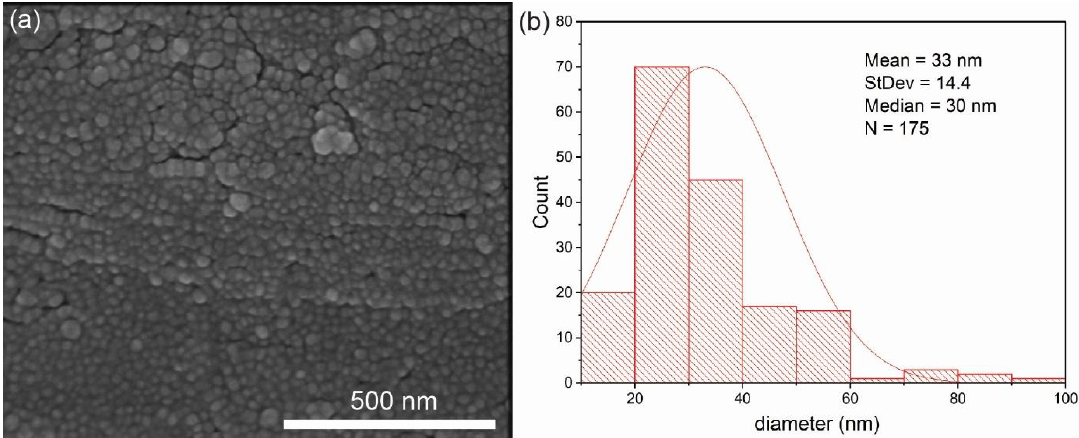
Figure 4. The surface of 80 × 800 (I) wire mesh covered with 50 nm layer of silver ( a ) and histogram of the size of the Ag nanostructures on the surface ( b ). The avarage size of these nanostructures is 33.0 nm ± 14.4 nm.